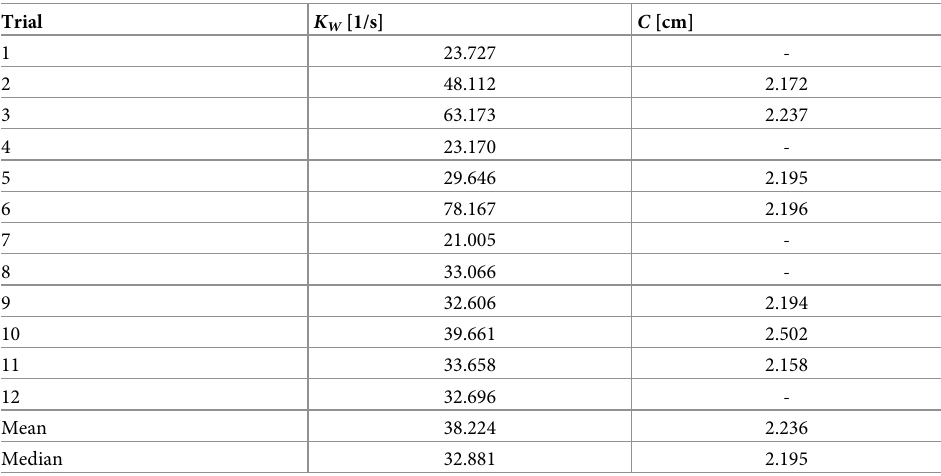
Table 1. Calibrated wall parameters for the 12 fish tested in standard illumination (condition Bright). For experi- ments in the dark, K W is set to zero and this form of interaction is absent. Trial K [1/s] C [cm] W 1 23.727